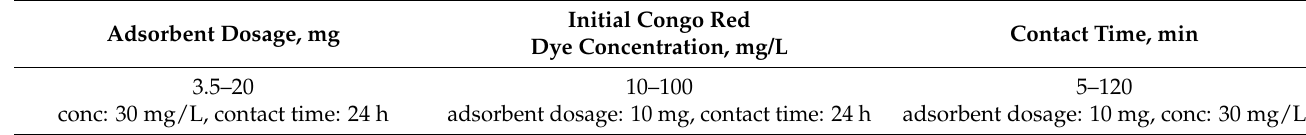
Table 1. Summary of applied experimental conditions in adsorption process of Congo red dye. Initial Congo Red Adsorbent Dosage, mg